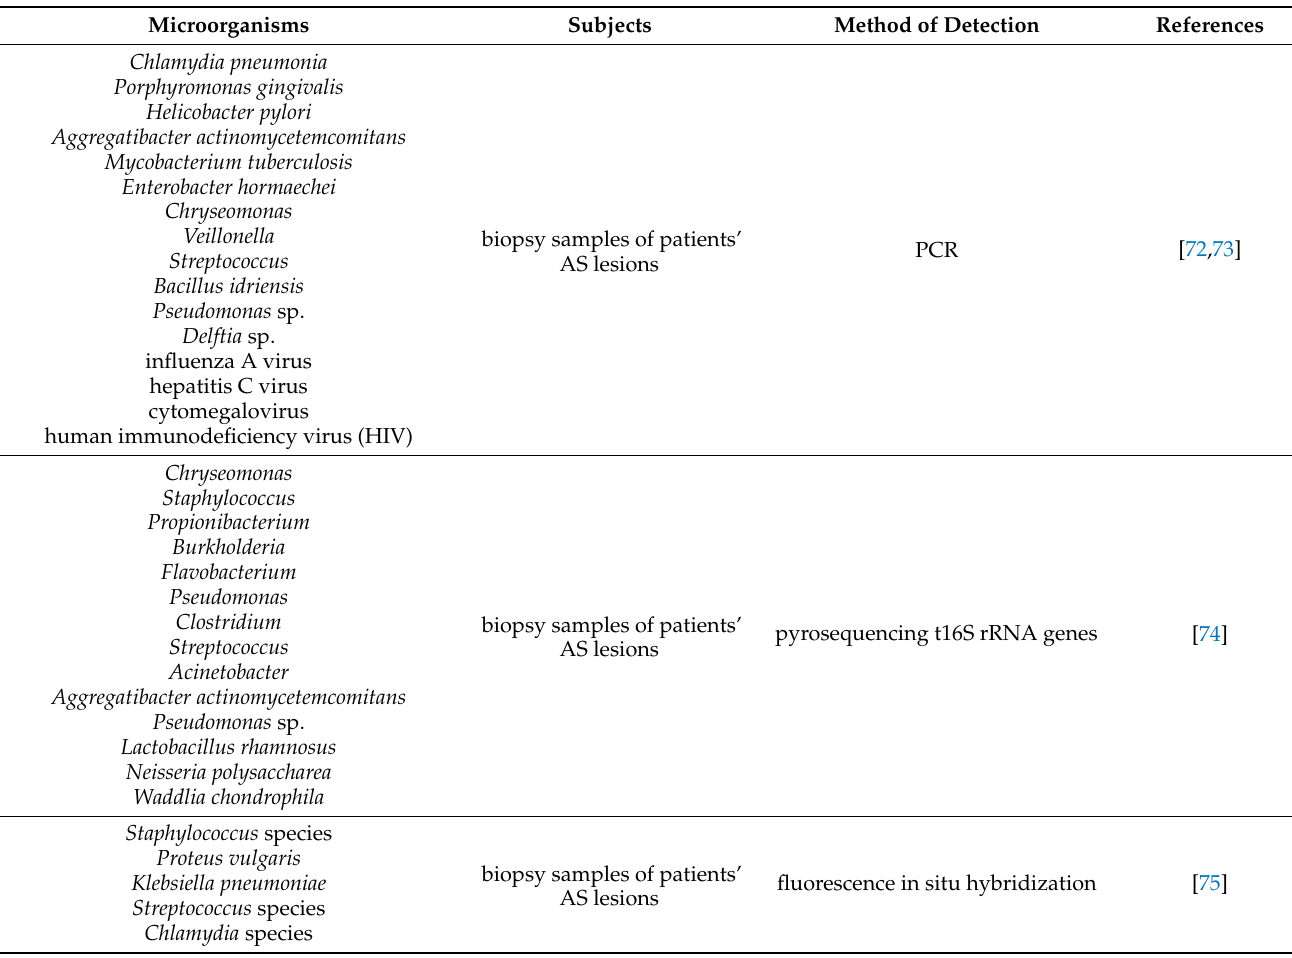
Table 1. Overview of the microorganism variety found in the AS